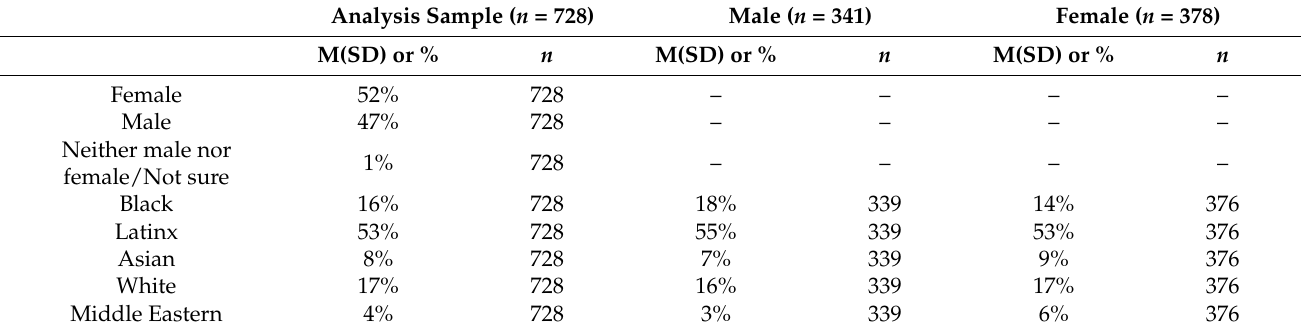
Table 1. Sample descriptive